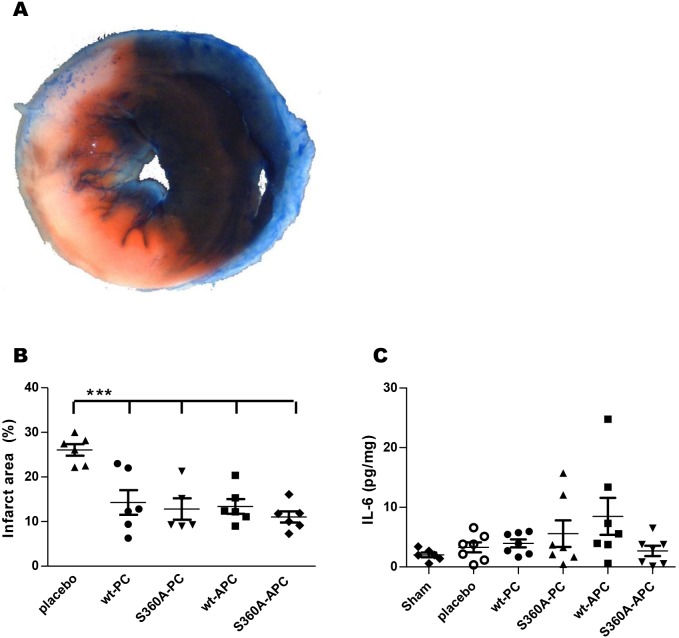
Treatment with wt- or S360A-(A)PC decreases infarct area.Mice were subjected to 1(0.4 mg/kg) or placebo (saline) were administered i.v. 15 min after induction of ischemia and a second time 5 minutes after induction of reperfusion. A) Representative picture of the Evans Blue/TTC staining after 2 h reperfusion. The normal tissue (non infarcted area) is stained dark blue, whereas the ischemic area (area at risk (AAR)) is stained brick red and the non-viable infarct area (area of infarction (AOI)) did not stain and remained pale. B) Infarct area (percentage AOI of AAR) as determined by Evans Blue/TTC staining. C) IL-6 concentrations were determined in heart tissue homogenates (5 mg/ml protein content) by ELISA and IL-6 per mg heart homogenate was calculated. All graphs show mean +/− SEM, statistical significance was tested using one-way analysis of variance with Dunnett post hoc test, ***P<0.001.